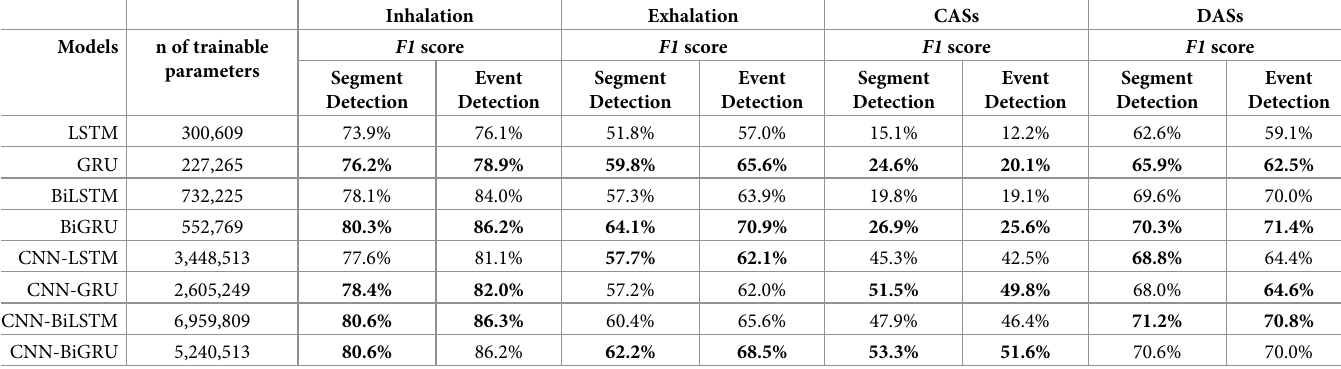
Table 4. Comparison of F1 scores between LSTM-based models and GRU-based